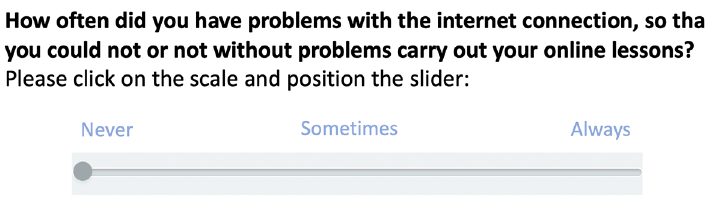
Figure 1. Example of scroll bar